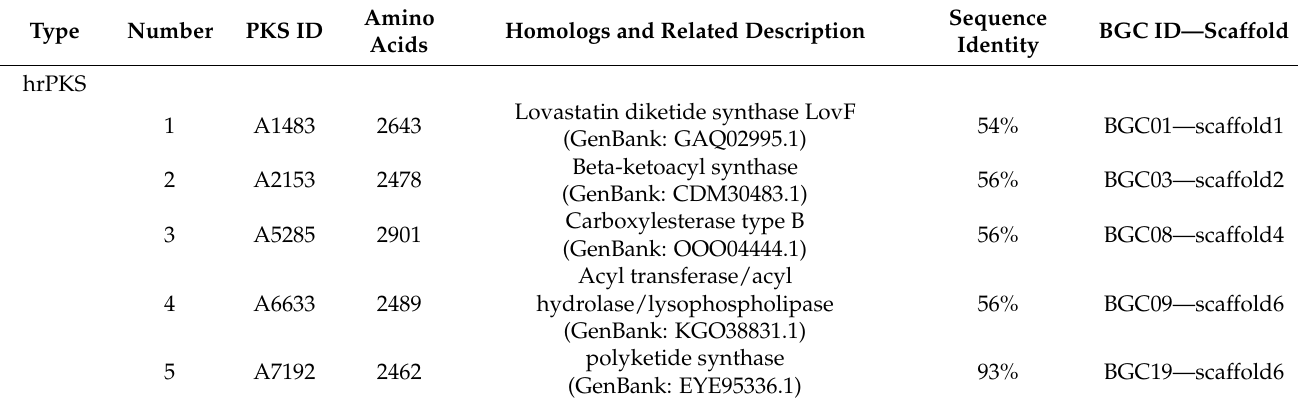
Table 3. Summary of putative PKS genes in the Eurotium cristatum E1